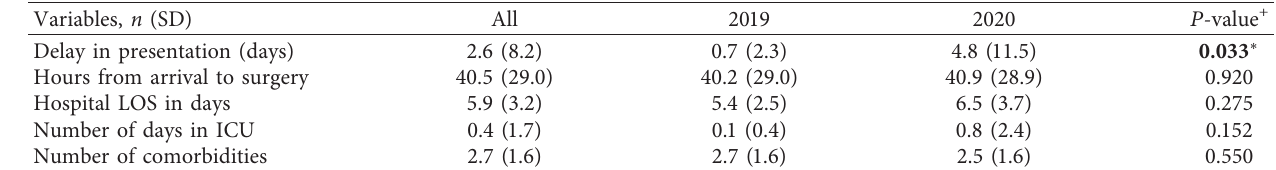
Table 3: Quantitative clinical characteristics of patients.